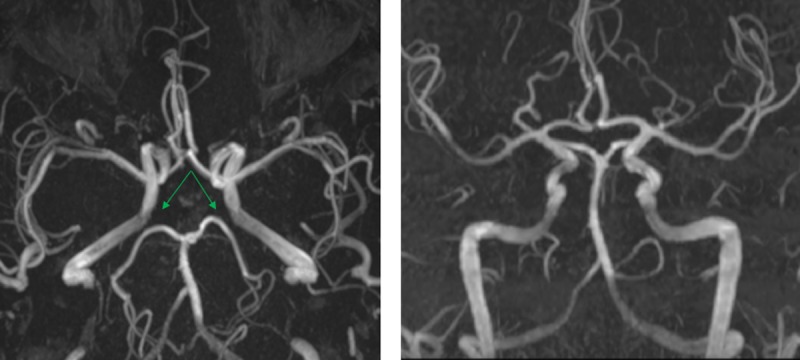
Absence of both posterior communicating arteries.Green arrows point to absence of both PCoA.